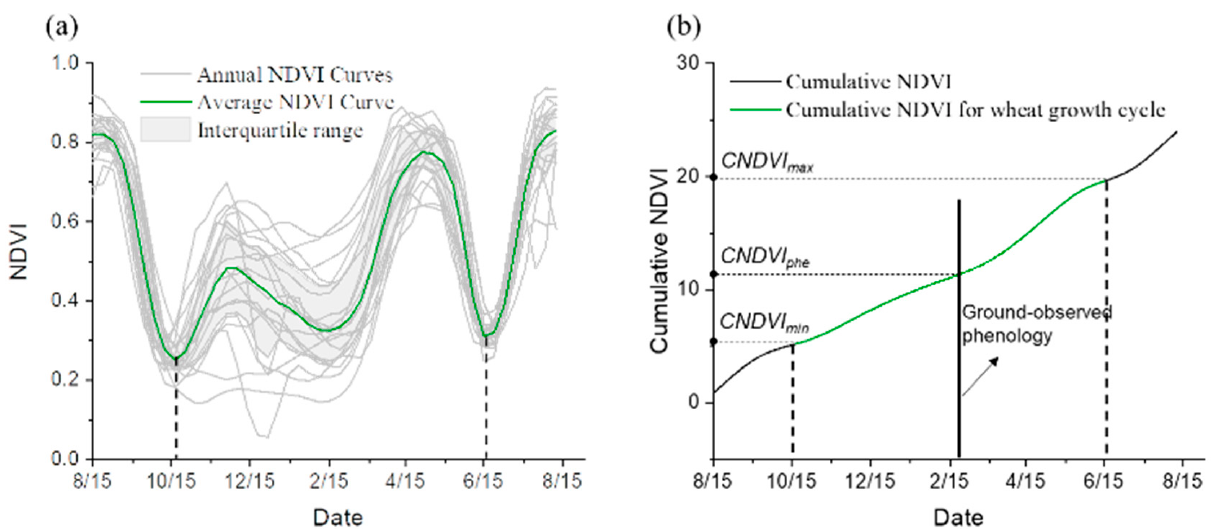
Figure 3. Schema to determine the relative threshold based on ground phenological observations. ( a ) represents annual NDVI curves for a specific wheat pixel, ( b ) illustrates how the relative threshold is determined based on ground phenological observations and cumulative NDVI curve. Table 1. Regression coefficients between phenological date and elevation, longitude, and latitude.